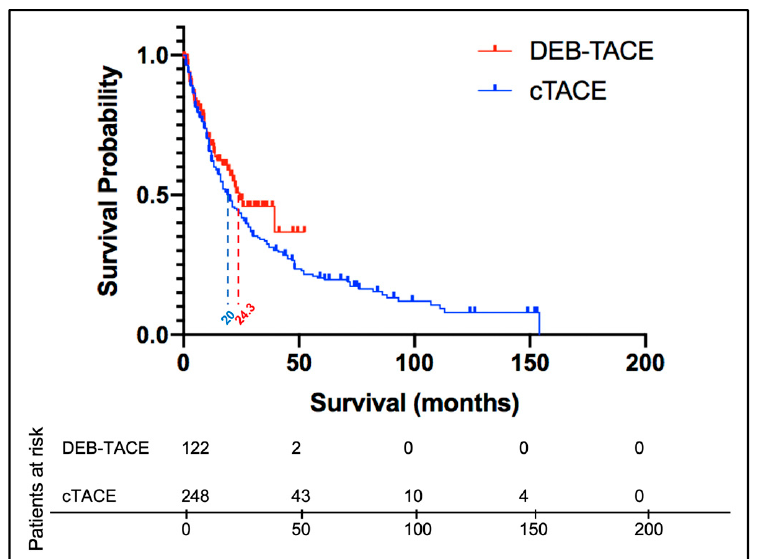
Figure 2. Kaplan-Meier curves demonstrating survival after propensity score weighting. Patients who received other combined liver-targeted therapies or liver transplantation after TACE were censored. Censored patients as well as those still alive at the end of the observation period are indicated in the survival curves as crosses (+). The median survival of the cTACE and DEB-TACE group was 20 months and 24.3 months (ratio 1.271, 95% confidence interval 0.876–1.69), respectively ( p = 0.392). DEB-TACE, drug-eluting beads TACE; cTACE, conventional transarterial chemoembolization.